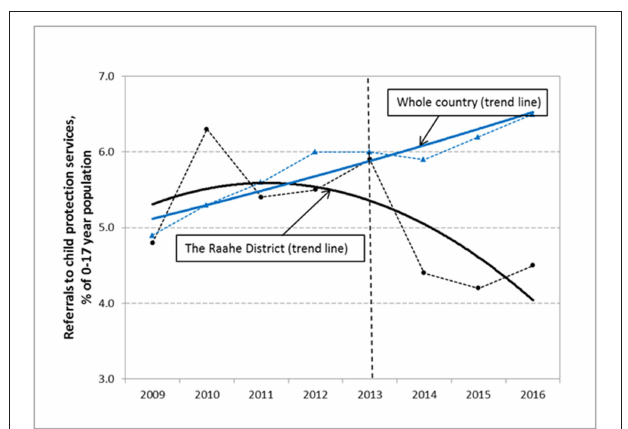
FIGURE 1 | The time trends (solid lines) and the observed percentage rates (dotted lines) of referrals to child protection services among the 0 to 17-year-old population in Raahe District and the whole country. The vertical dotted line indicates the year 2013 from which the Let’s Talk about Children Service Model was in the routine use in the services of